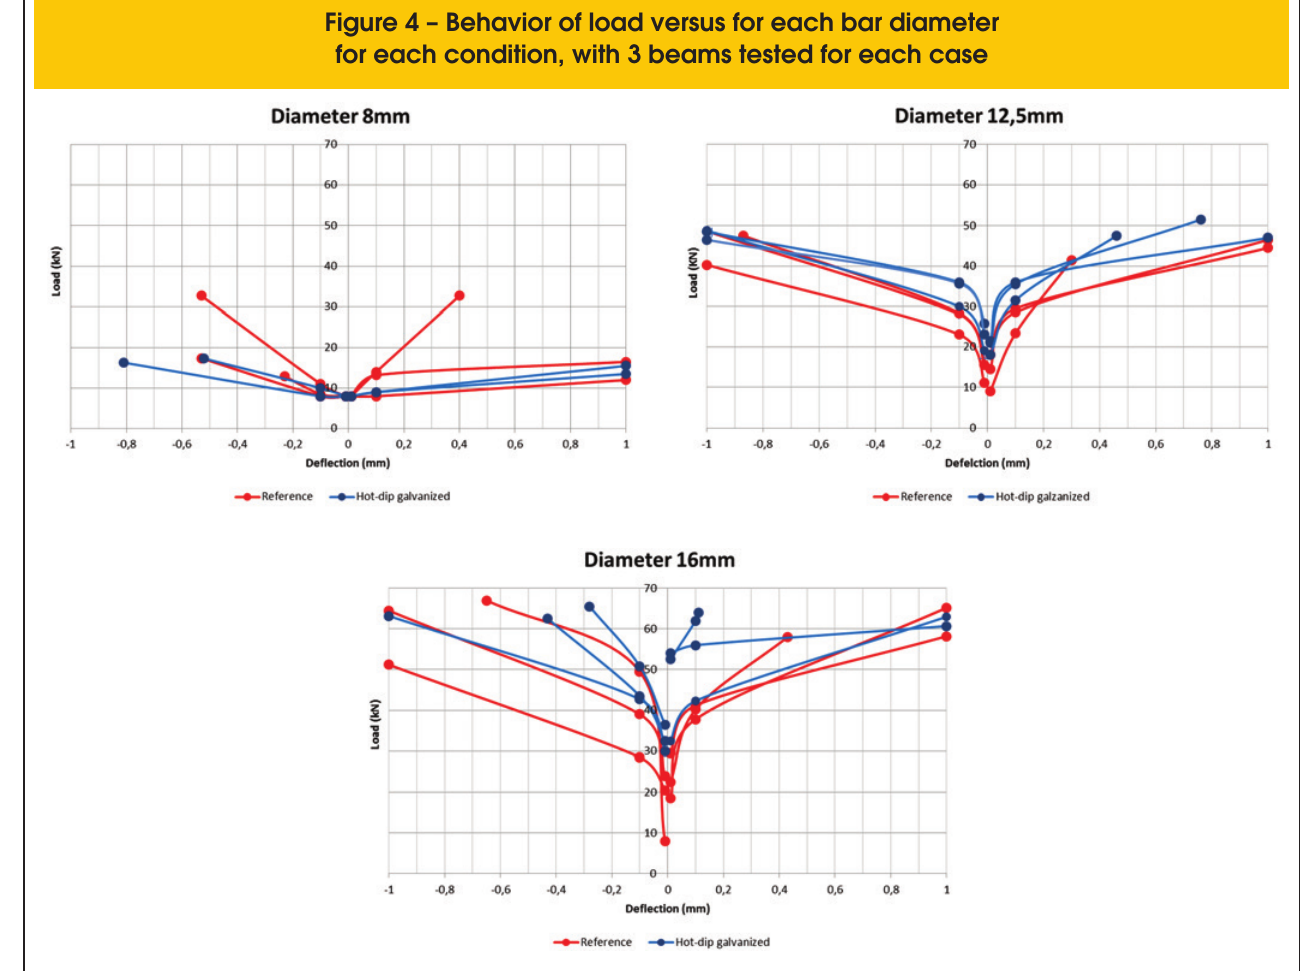
Figure 4 – Behavior of load versus for each bar diameter for each condition, with 3 beams tested for each